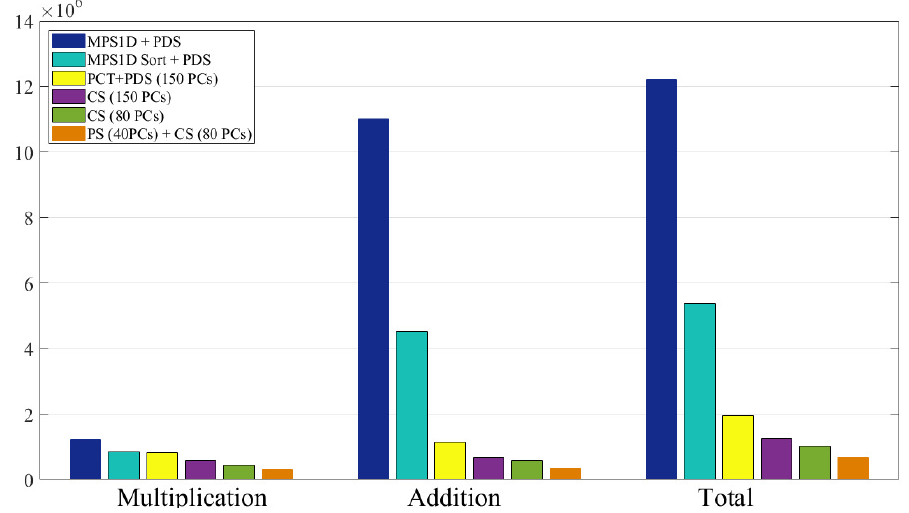
Figure 5. Average number of multiplications and additions operations of major